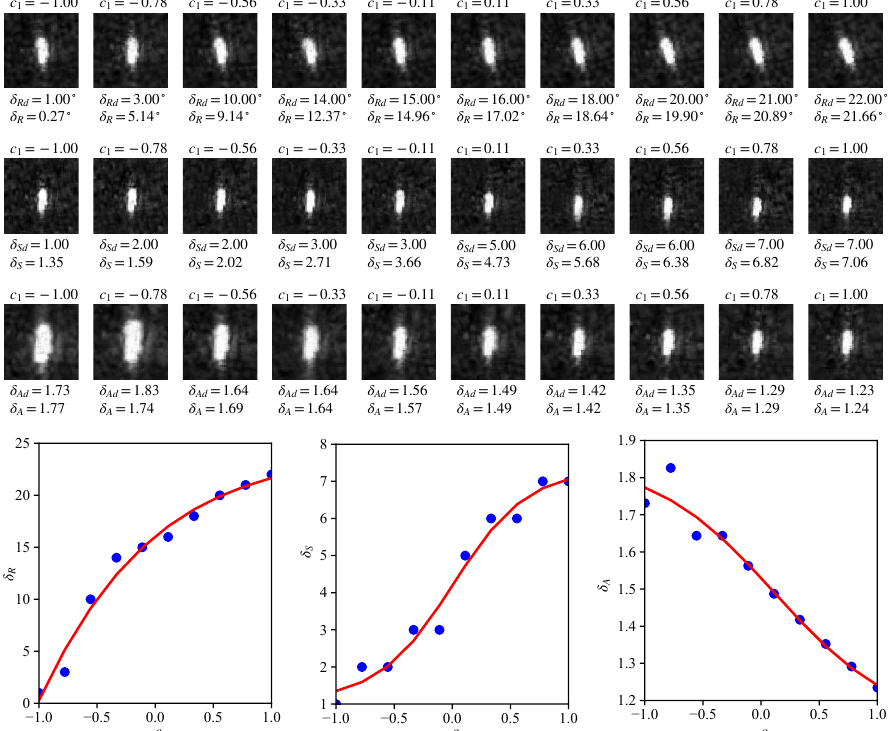
Figure 16. Some experimental results of AIR-SARShip-1.0 dataset. The first, second, and third rows are SAR images produced by InfoGAN with one latent code, c 1 ∈ [ − 1,1 ] , corresponding to rotation, translation, and scaling, respectively. The fourth row shows the comparison between measured rotation (left), translation (middle), and scaling (right) by blue dots and corresponding estimated properties (red